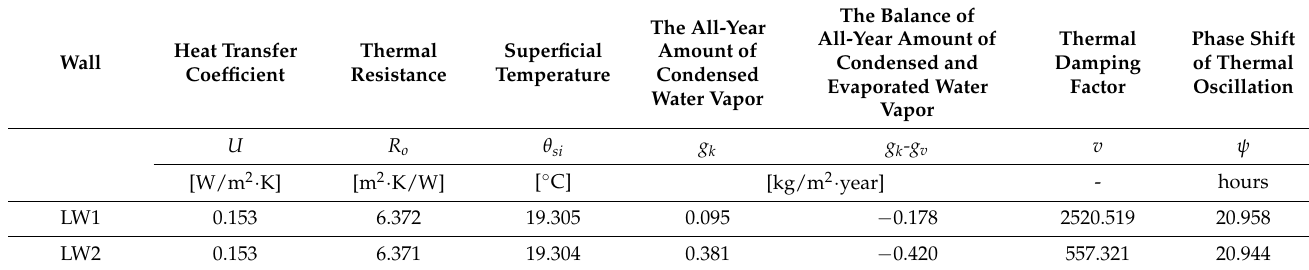
Table 1. Thermal performance properties of the sample walls LW1 and